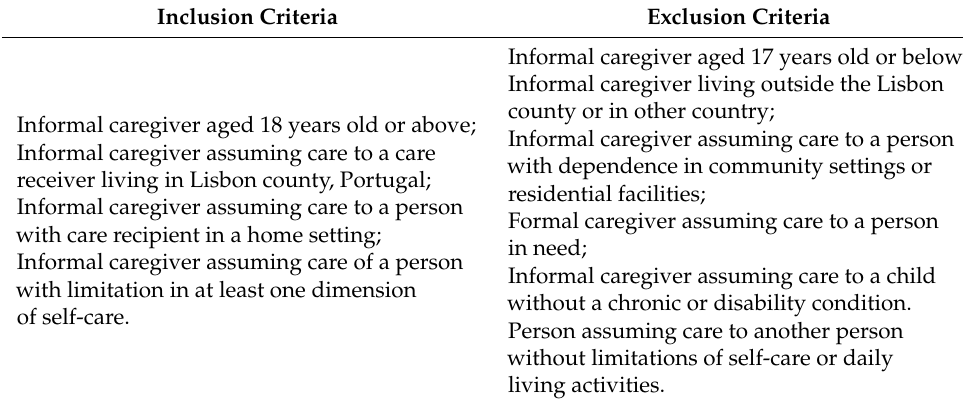
Table 1. Inclusion and exclusion criteria. Inclusion Criteria Exclusion